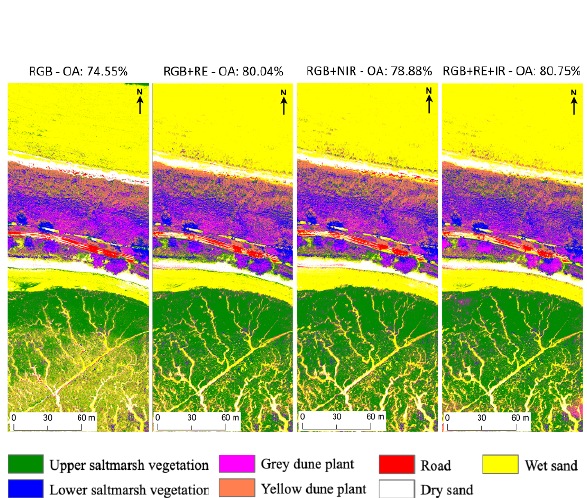
Figure 7. Maximum likelihood classification from the Gram- Schmidt pansharpening.